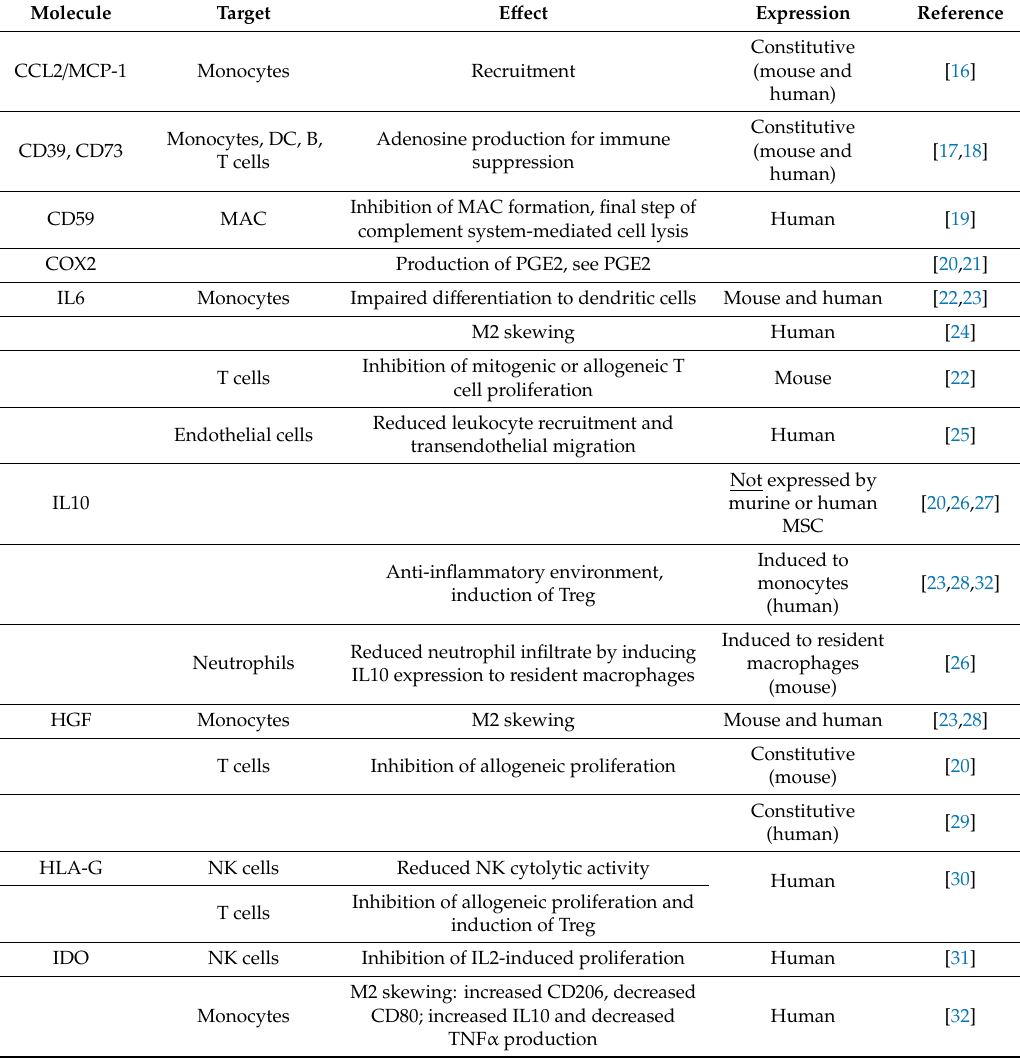
Table 1. Major immune mediators by MSC.The e ff ect on target cells is indicated as well as its expression (constitutive / inducible when specifically known, and